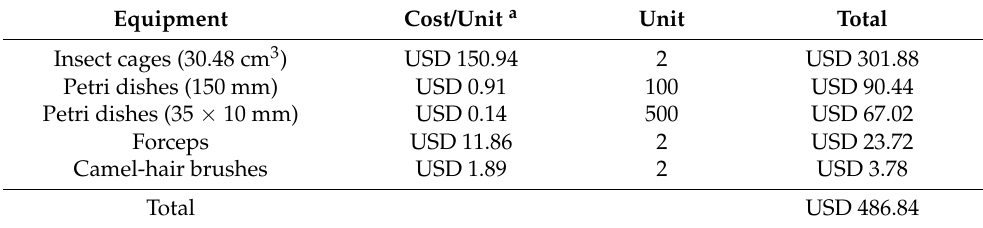
Table 1. The initial investment cost for producing 20 P. maculiventris and 20 E. floridanus eggs to adults.